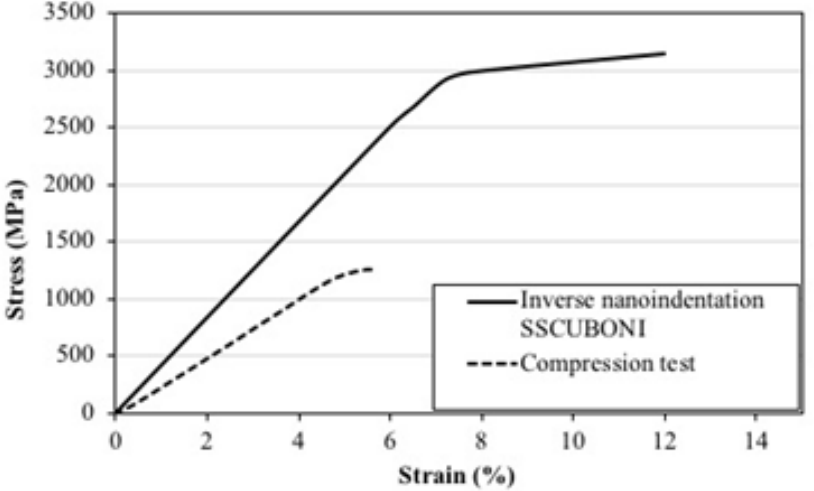
Figure 12. Comparison of the S-S curves of the experimental compression test with the corresponding inverse SSCUBONI-based experimental test for the W-Cu